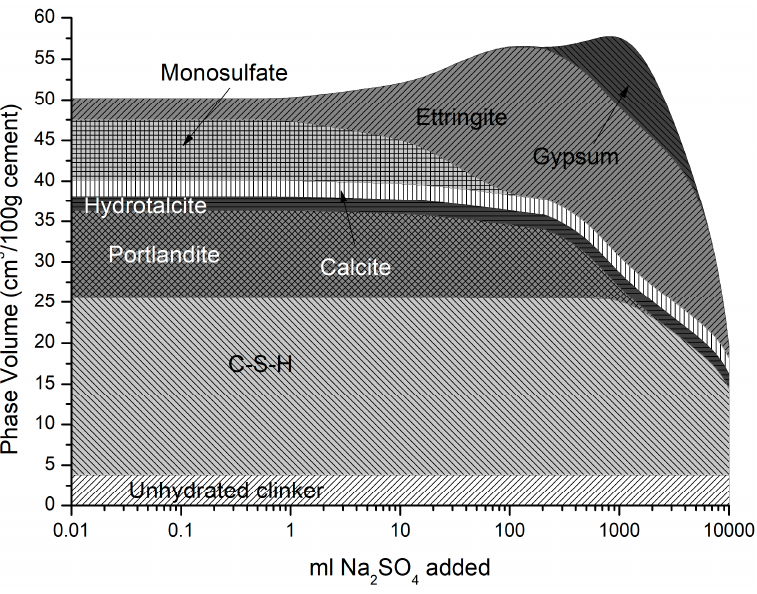
Figure 15. Phase assemblage with increasing sulfate concentration at 80 °C . The effect of seawater on the phase assemblage of a hydrating cement used a break- down of the chemical elements from a sample of Atlantic Ocean water [36]. The Atlantic oceans and seas. Table 10 shows the composition of seawater taken from the East coast of Scotland which lies along the North Sea. As may be seen, compared to the Atlantic (Table 9), the levels of aggressive ions are much lower. For instance, in terms of chlorides, which are responsible for most mild steel reinforcement corrosion [59], the Atlantic has almost twice the chloride content (15,704 ppm). Using the concentrations in Table 10, Figure 16 shows the change in phase assemblage with increasing North Sea water. There is little difference in behaviour between both except for slightly less Friedel salt and expansive ettringite in the reaction of the North Sea water. There is also additional M-S-H and brucite as well as less C-S-H and portlandite in the Atlantic Ocean analysis, which may be due to the slightly more acidic conditions at higher water contents, as shown in Figure 17. As with the above environments, this analysis will provide concrete designers and suppliers with valuable insights as to the likelihood of possible durability issues in saline environ- ments and ensure that monitoring in extreme environments [61] can maintain perfor- mance-based standards (EN 206, [62]). Table 10. North Sea seawater analysis (taken from [36]). Element